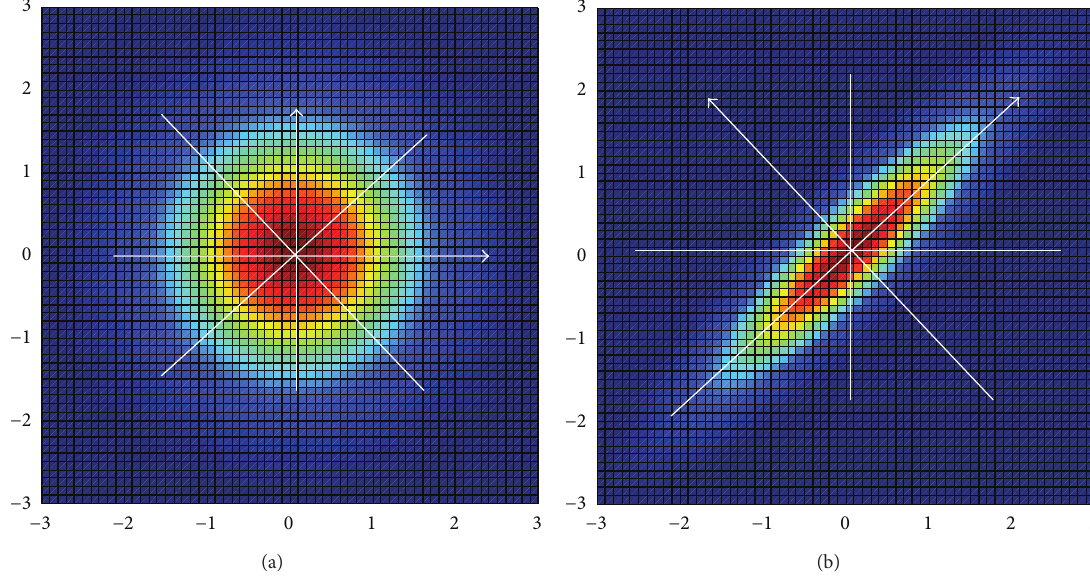
Figure 2: The illustration of distinguishing spherical class from chain-shaped class. A given class is divided into 8 parts along the 8 lines through the centroid of the class. If the class is spherical, the percentage of each part is close to threshold 𝜀 = 1/8 . If the class is chain-shaped class (or part of chain-shaped class), there are 2–4 parts whose percentage is far less than 1/8. Therefore, the percentage of each part is the marker of spherical class. 𝜀 = 0.058 in this paper because some classes are elliptical.